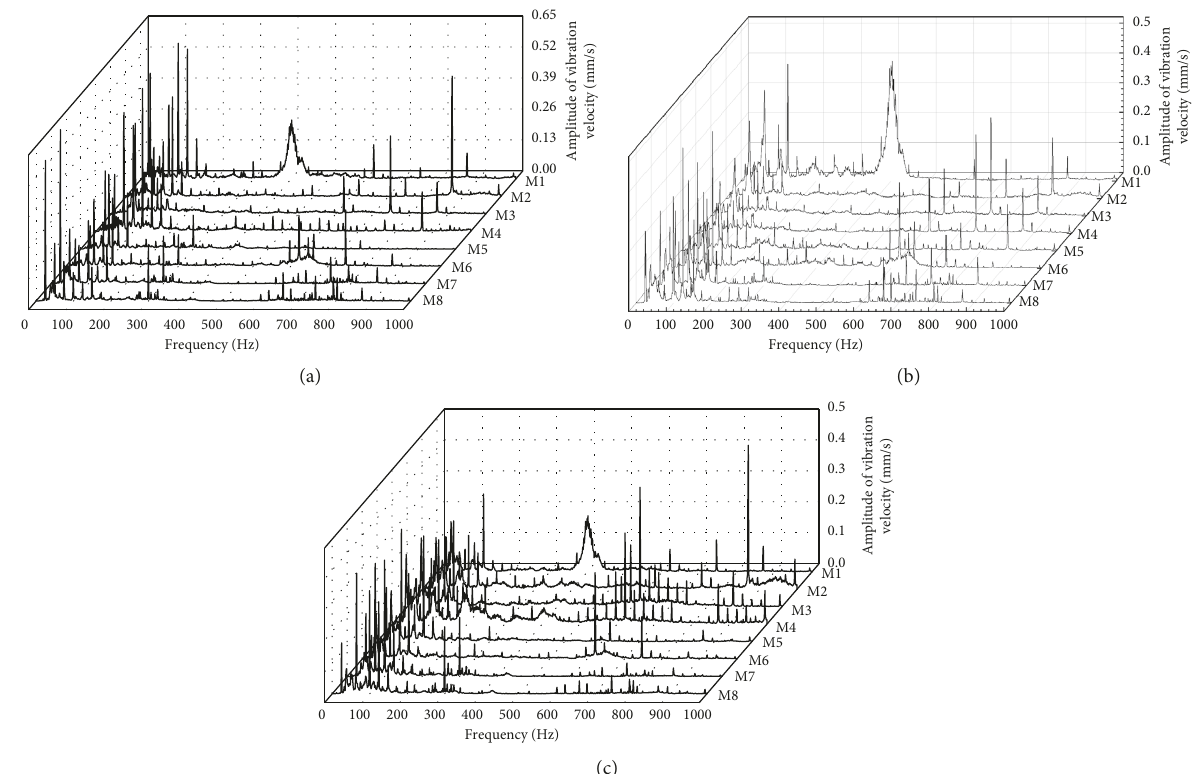
Figure 8: Frequency domain of vibration at M1 ∼ M8 in the (a) X direction, (b) Y direction, and (c) Z direction.